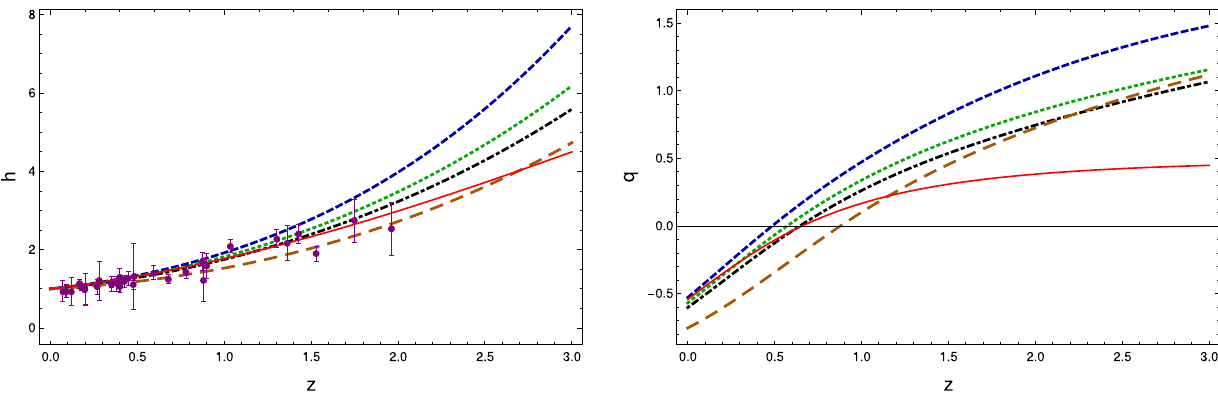
Fig. 1 The evolution of the Hubble and deceleration parameters as a function of redshift z for β = 0 . 001 (dashed), 0 . 05 (dotted), 0 . 1 (dot-dashed) and 0 . 5 (long dashed). The red solid line represents the evolution in the (cid:2) CDM model. Also, error bars correspond to the observational data